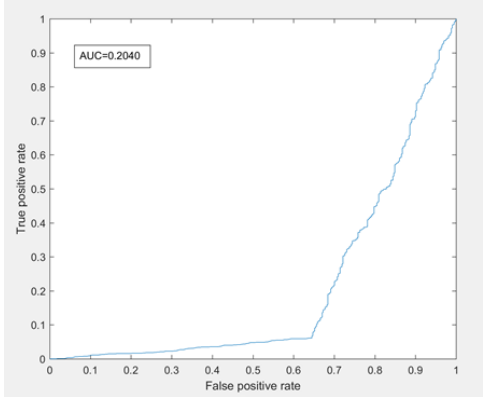
Figure 7. ROC curve for INRIA